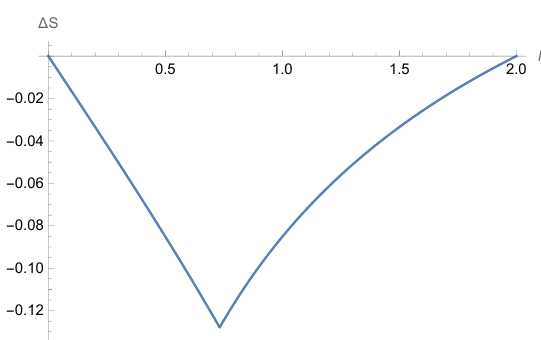
Figure 19 . The horizontal axis is ‘ and the vertical axis is ∆ S where r 0 = 1 , r 1 = 3 , and c = 1 . We can see a phase transition by comparison of Γ Q